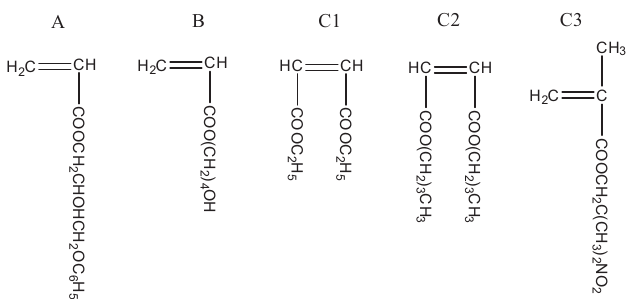
FIGURE 2 - The structure of acrylate monomers.